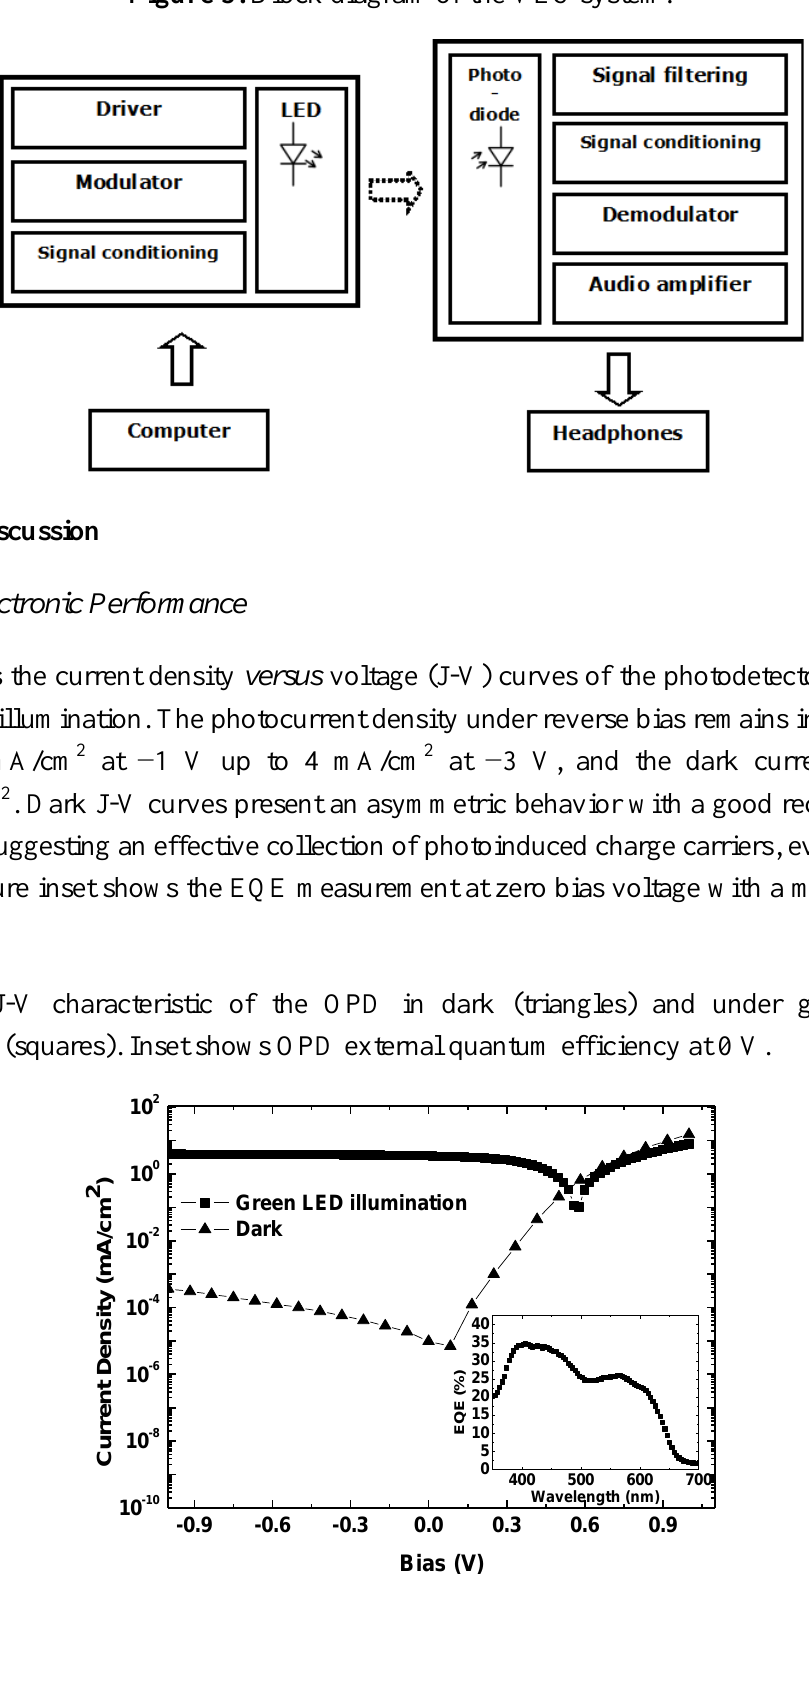
Figure 3. Block diagram of the VLC system.